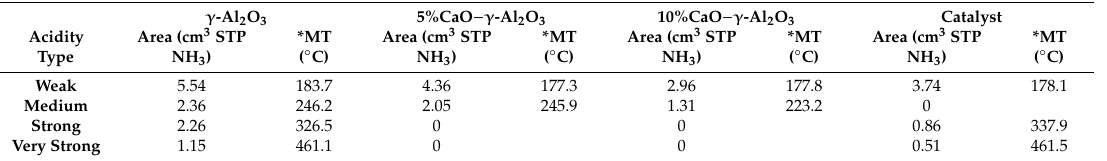
* MT: maximum temperature ( ◦